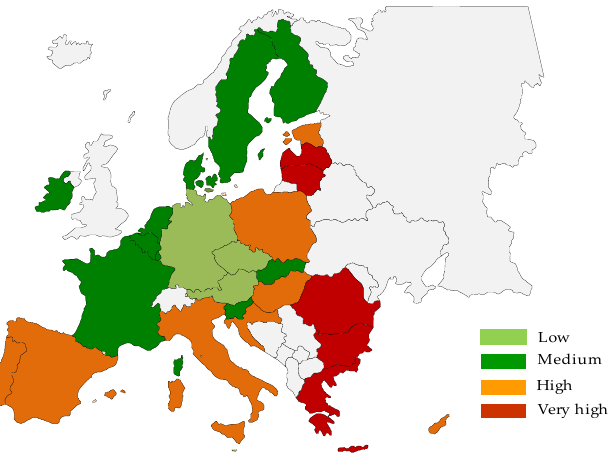
Figure 2. Spatial delimitation of types of EU countries in terms of poverty level in 2010.